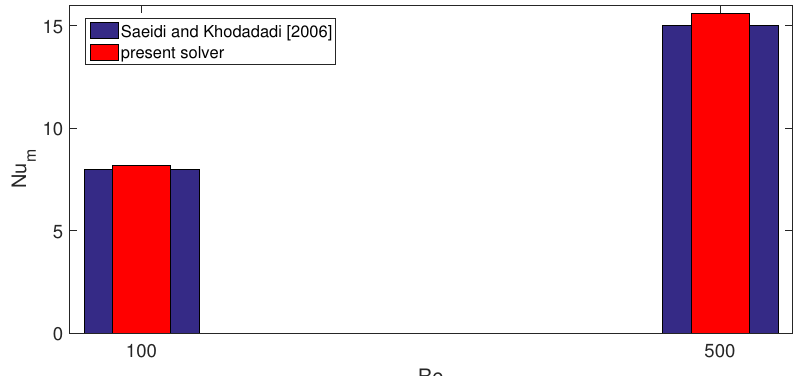
Figure 5. Average Nu comparisons between the results of Ref. [1] at two different Re where forced convection in a VC with one inlet/outlet port is